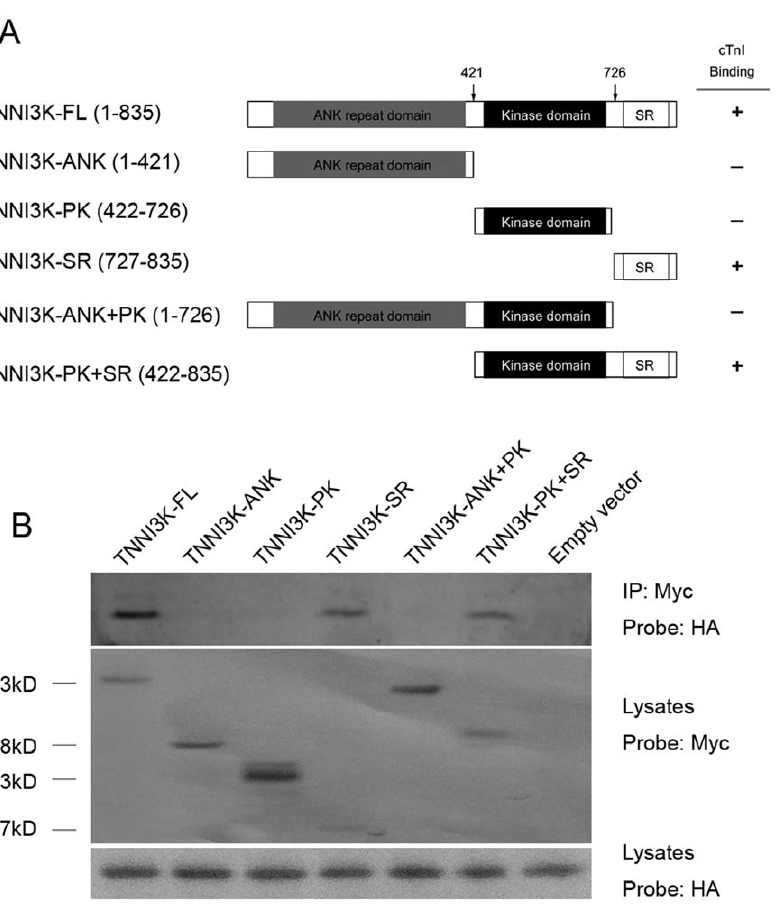
Figure 6. cTnI interacts with the serine-rich domain in the carboxyl terminus of TNNI3K. (A) Schematic representation of cTnI TNNI3K binding results. The selected domains on TNNI3K were indicated by labeled boxes. FL: full length, ANK: ANK repeat domain, PK: protein kinase domain, SR: serine rich domain. (B) H9C2 cells were transiently transfected with plasmids expressing full-length HA-tagged cTnI and the full-length Myc-tagged TNNI3K or the indicated truncations of Myc-tagged TNNI3K. TNNI3K was immunoprecipitated (IP) with anti-Myc antibodies and the presence of cTnI in the immunoprecipitate was assessed by immunoblotting with anti-HA antibodies. The expression of myc-TNNI3K from transfected constructs in the lysates is shown on the middle panel. The abundant of HA-cTnI in the lysates probed with anti-HA was used as an input.